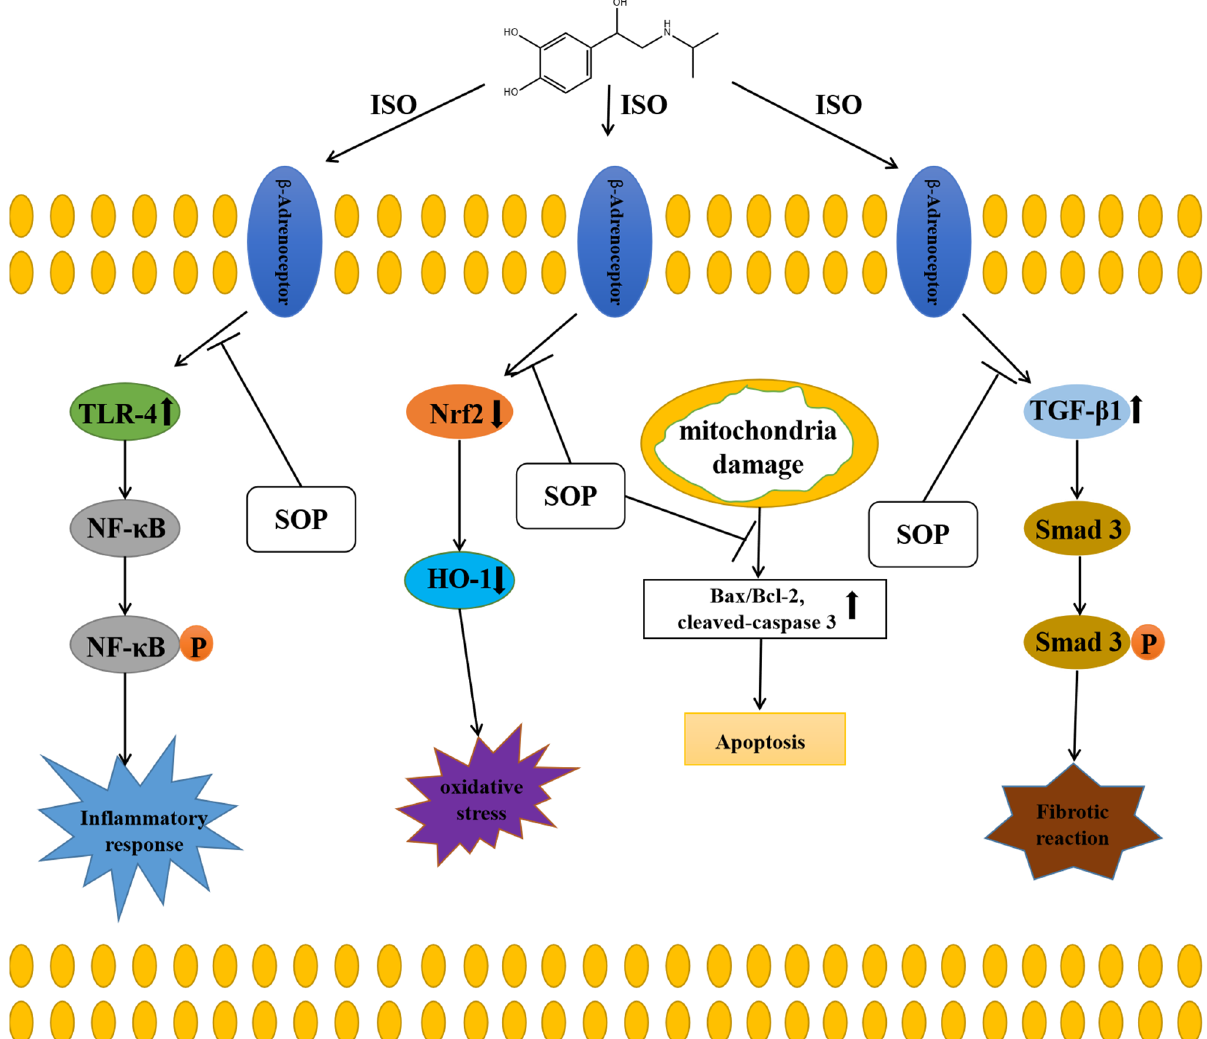
Figure 6. Graphical abstract of the effects of treatment with SOP on ISO-induced kidney injury: SOP could alleviate ISO-induced kidney injury by inhibiting inflammation, apoptosis, oxidative stress and fibrosis; the molecular mechanisms were suppression of the TLR-4/NF- κ B and TGF- β 1/Smad3 signaling pathways and activation of the Nrf2/HO-1 signaling pathway.